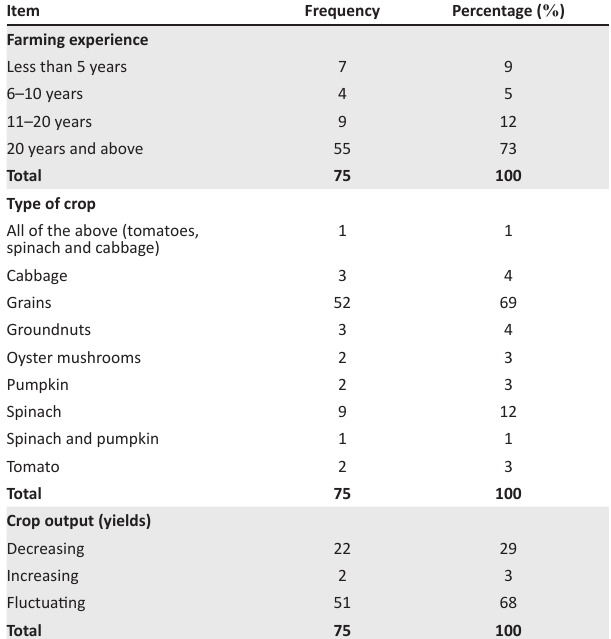
Source : Primary data collected for the study.